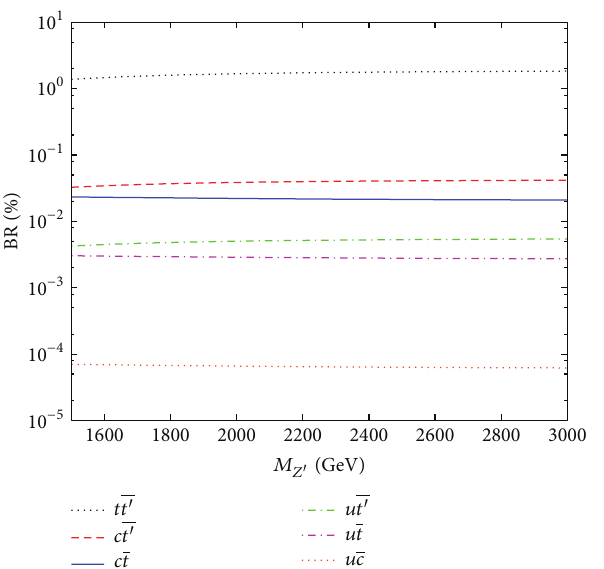
Figure 7: Branching ratios (%) depending on the mass of the 𝑍 󸀠